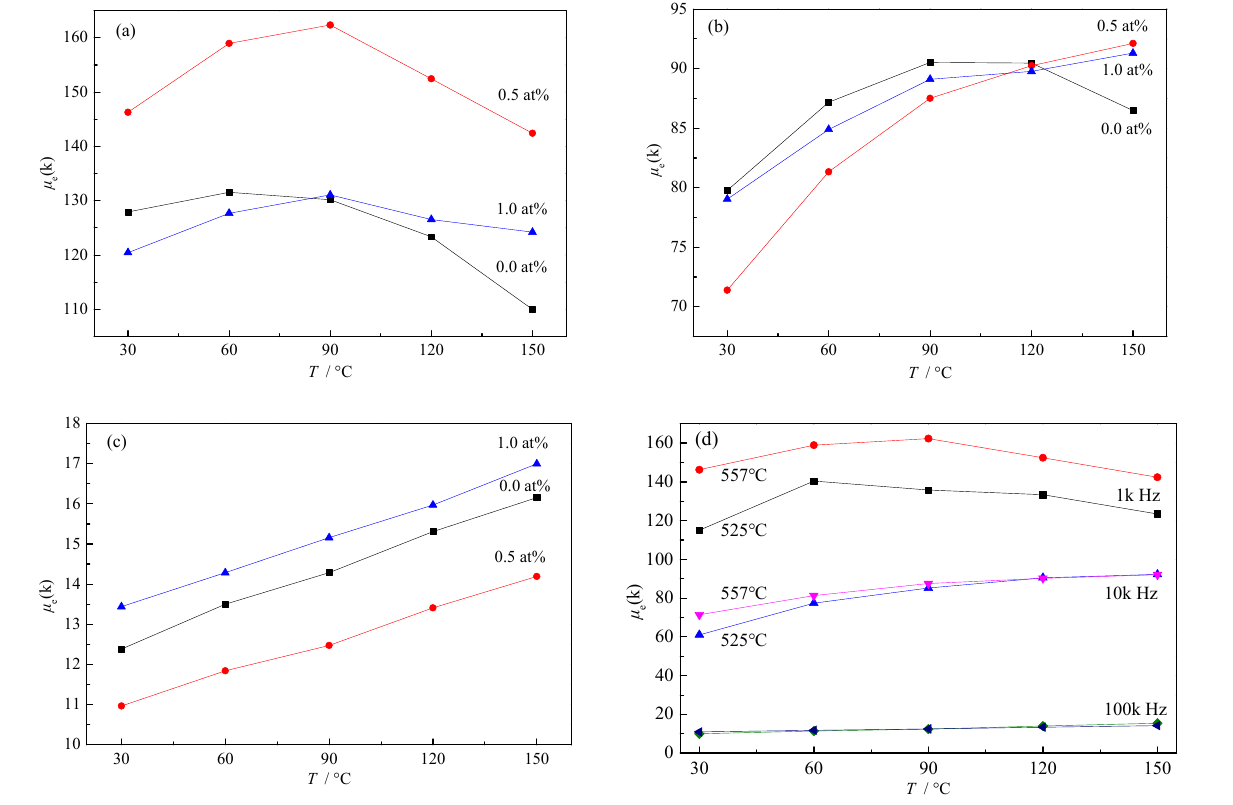
Figure 7. Evolution of μ e values in the temperature range of 30–150 °C: ( a – c ) μ e values at 1 kHz, 10 kHz, and 100 kHz, respectively (annealed at 557 °C); ( d ) performance comparison of 0.5% Gd alloys annealed at different temperatures.